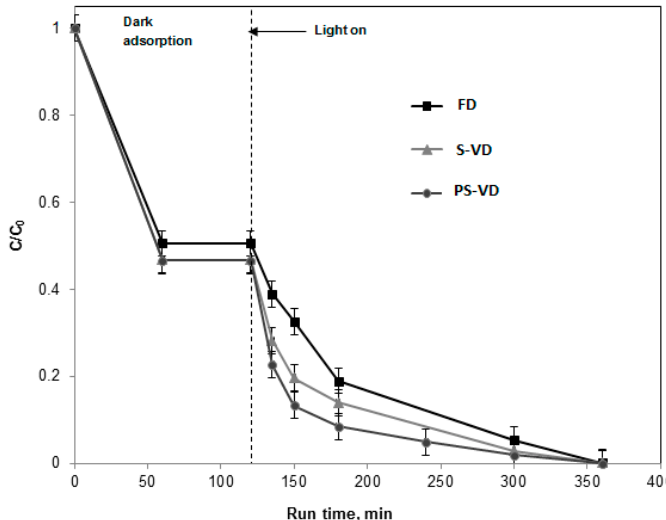
Figure 4. Behavior of urea’s relative concentration as a function of run time in the dark phase and under visible light irradiation obtained by using FD LED dimming (48 W, 200 mA), S-VD LED dimming modulation, and PS-VD LED dimming modulation (25–78 W, 100–300 mA). Urea initial concentration: 250 mg / L; solution volume: 250 mL; N-TiO 2 / PS amount: 120 g.